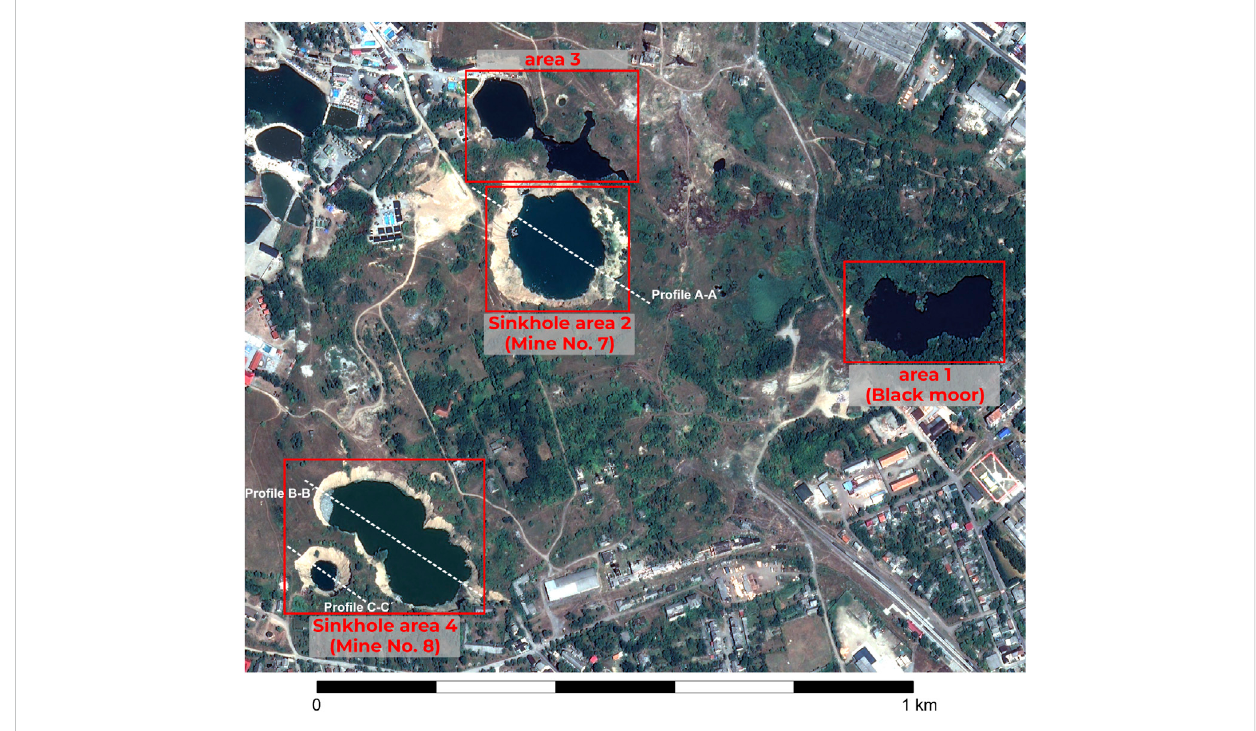
FIGURE 8 Detail of the point cloud and DTM of the monitored area in